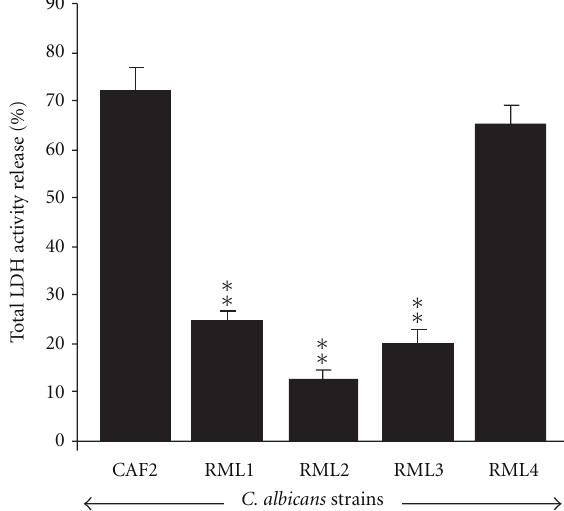
Figure 4: LDH release following EHOM infection with C. albicans strains. Culture media were collected from the noninfected and infected EHOMs. Supernatants were used to assess LDH release by means of specific kits. Data are means + SD, n = 5. ∗∗ P < 0 . 01 compared to the control (CAF2-infected